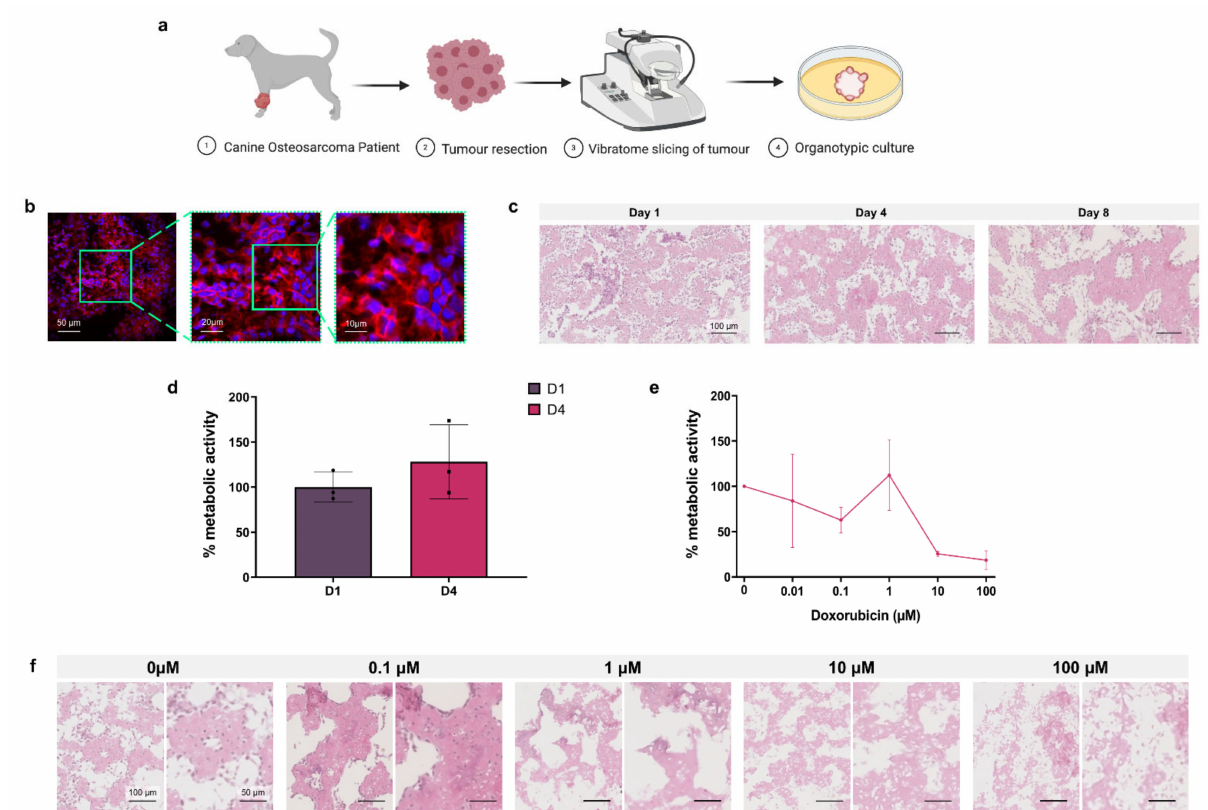
Figure 6. Osteosarcoma canine model. ( a ) Project workflow. Osteosarcoma is resected from the canine patient, organotypic slices are obtained by vibratome and are cultured in vitro. ( b ) Fluorescent microscopy of tumour slices labelled with DAPI (nuclei, blue) and phalloidin (F-actin, red). ( c ) H&E staining of organotypic slices at day 1, 4, and 8. ( d ) Metabolic activity of organotypic culture at day 1 and 4 expressed as % of day 1. Data is expressed as Mean ± SD of n = 3 samples. ( e ) Organotypic slices after treatment with scalar doses of doxorubicin at day 4 represented as % metabolic activity relative to untreated control D4/D1 of n = 3 samples. ( f ) H&E staining of organotypic slices treated with scalar doses of doxorubicin at day 8. Data is expressed as Mean ±